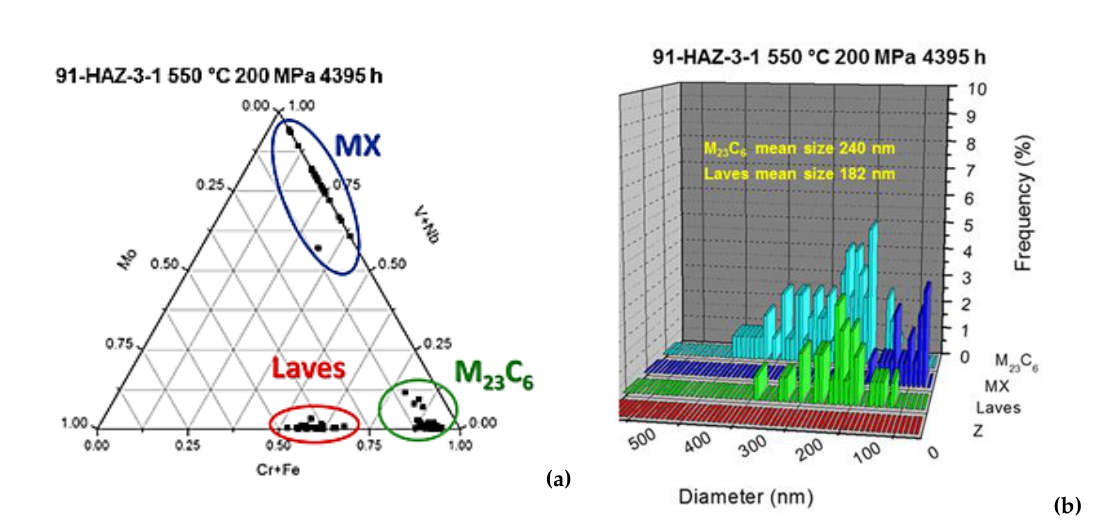
Figure 5. Subproject N°3: GR 91 HAZ CREEP, ternary diagram ( a ) and size distribution ( b ) (TEM analysis).